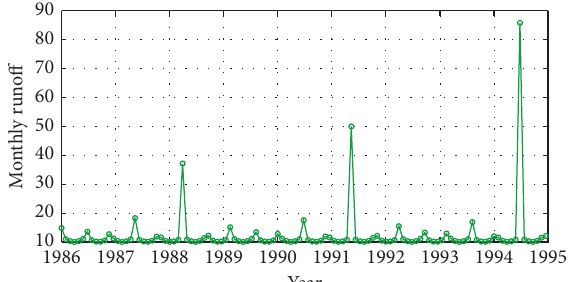
Figure 7: Simulated results of monthly runoff in the cocoon field after calibration (1986 ∼ 1995).